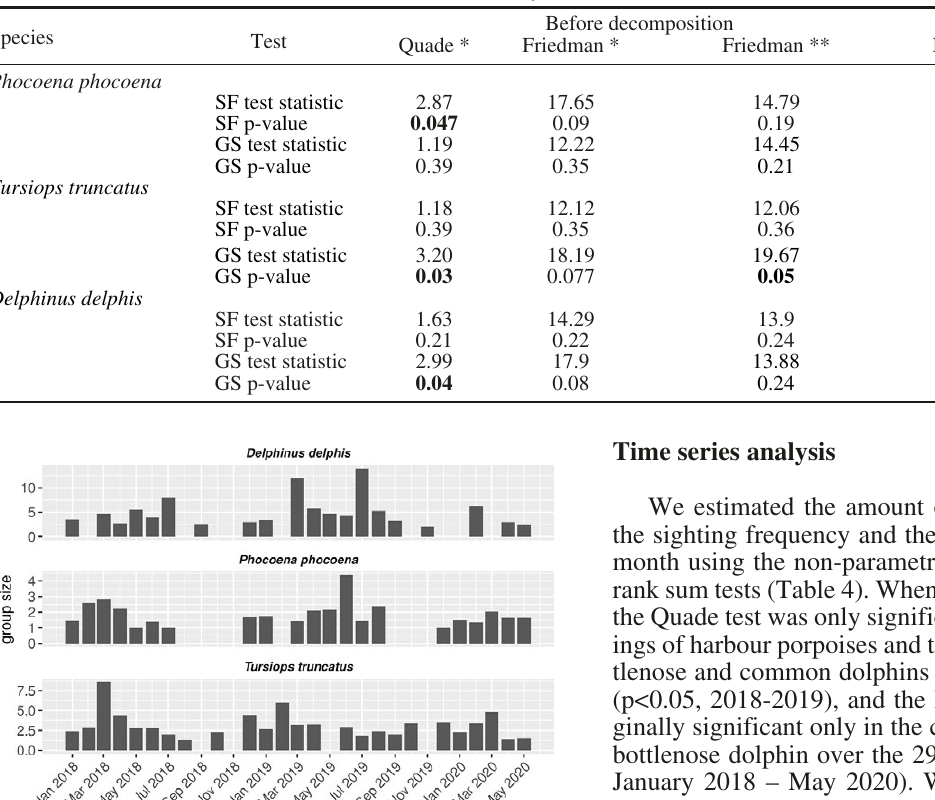
Table 4. – Non-parametric tests of seasonal variation before and after decomposition of the respective time series. Significant values are in the bold font. SF, sighting frequency; GS, mean group size. * Test performed on the two-year data 2018-19 (24 months); ** Data from January-